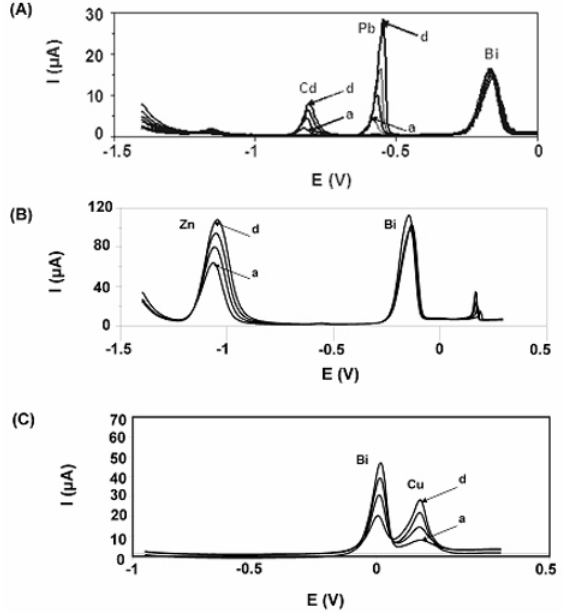
Figure 5. Measurements of (A) Pb( ΙΙ ) and Cd( ΙΙ ), (B) Zn( ΙΙ ) and (C) Cu(II) in bovine liver BCR-CRM 185. Square-wave stripping voltammograms show a mussel tissue sample (a) and three standard additions (b - d) of 5 μg L -1 of each metal. Preconcentration potential -1.4 V for a preconcentration time of 180 s; “cleaning” for 30 s at +0.3 V (for the GCE) or at -1.5 V (for the CFE). Other experimental conditions as described in sections 2.5 and